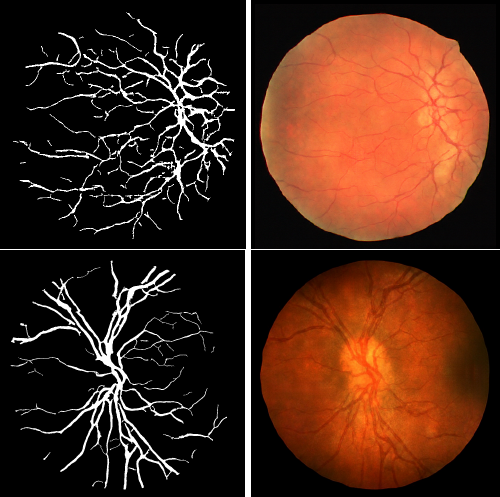
Figure 9. Examples of generated images with an unrealistic optical disc and vasculature from DRIVE ( top ) and CHASE _DB1 ( bottom